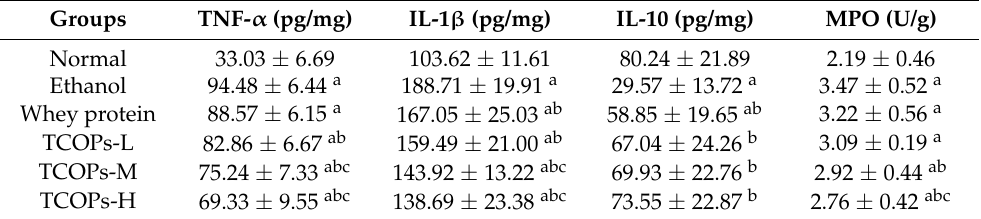
Table 7. Effect of TCOPs on the content of inflammatory factors in duodenal tissue of rats.